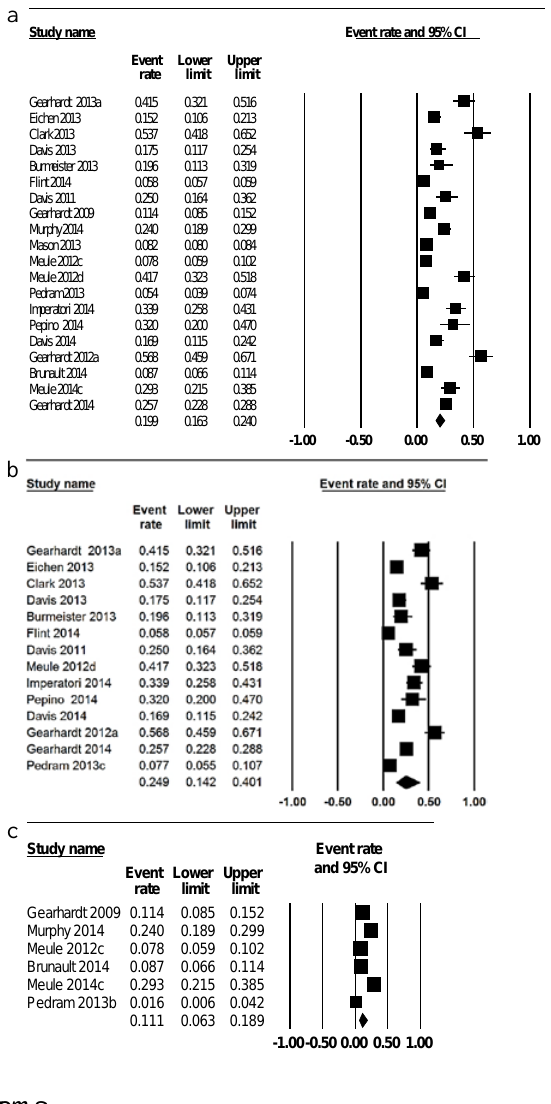
Figure 2. ( a ) Meta-analysis of Yale Food Addiction Scale Diagnosis for all studies; ( b ) Meta-analysis of Yale Food Addiction Scale Diagnosis for overweight/obese samples; ( c ) Meta-analysis of Yale Food Addiction Scale Diagnosis for healthy weight